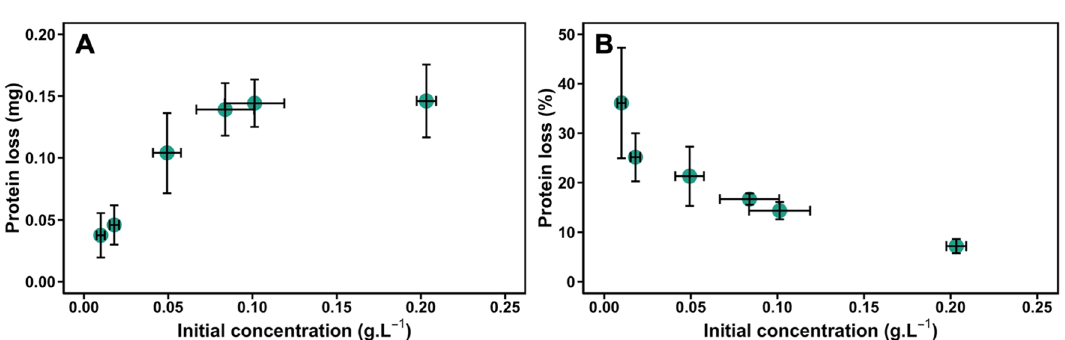
Figure 4. Effect of the initial protein concentration on the protein loss for YPE cell extract. ( A ) Absolute protein loss in mg. ( B ) Percentage of protein loss. Samples were gently mixed in PP tubes on a rotating wheel at 3 rpm during 4 h at 6